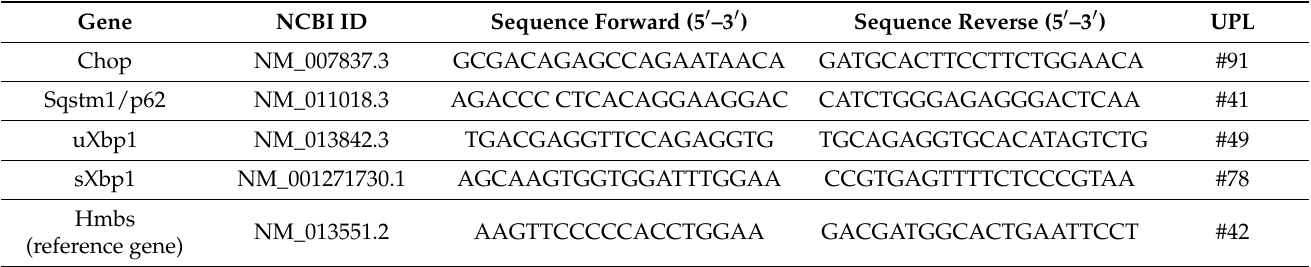
Table 1. List of qRT-PCR primer pairs and universal probe library (UPL)